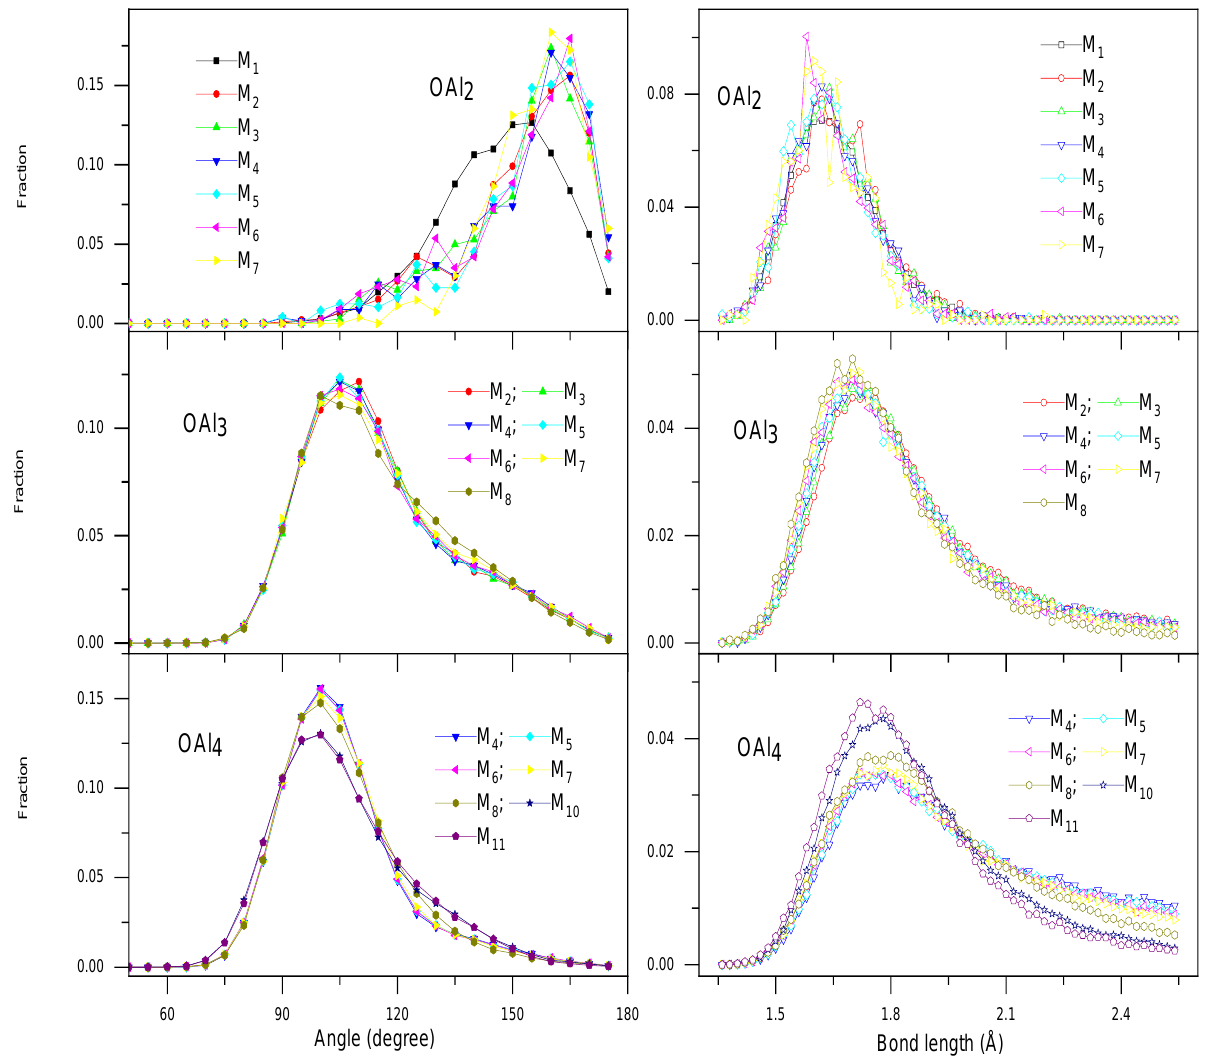
Figure 4. Bond angle Al-O-Al (left) and length (right) distribution in coordination units OAl y at different